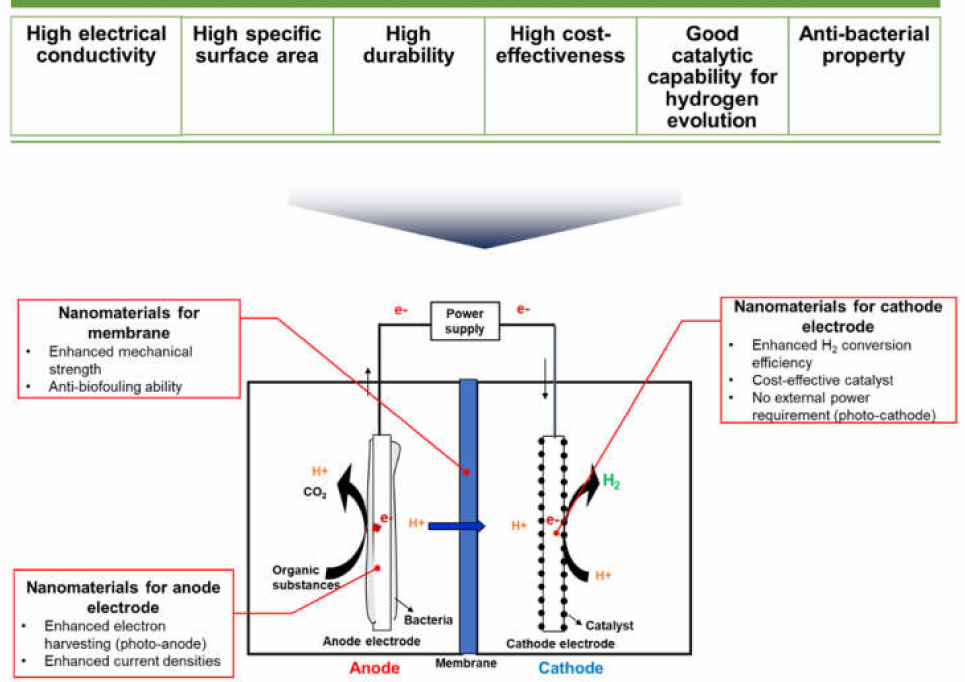
Figure 3. Various applications of nanomaterials in microbial electrolysis